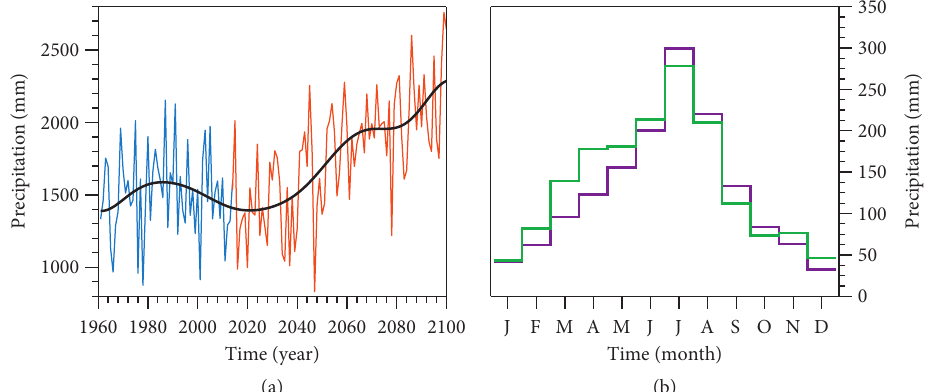
Figure 7: Precipitation change in the Meishan reservoir area in SSP370 scenario. (a) Multimodel ensemble precipitation projection from 2015 to 2100 (orange) and the comparison with the historical observation from 1961 to 2014 (blue). The black line is the 30-year low-pass curve by the Lanczos filter. (b) The monthly precipitation climatology from 1961 to 2014 historical observation (purple) and 2061–2100 multimodel ensemble